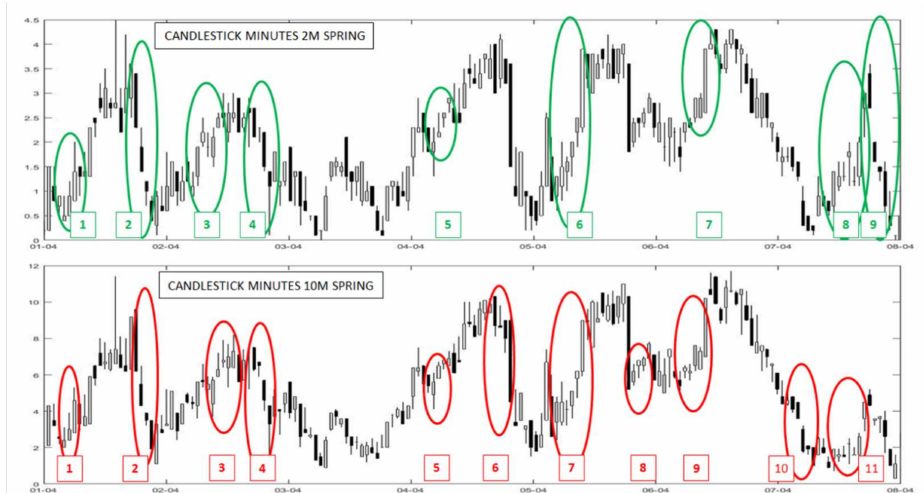
Figure 6. Candlestick chart for Los Montes del Cierzo, hourly resolution, first week of April 2017, at 2 m ( top ) and 10 m ( bottom ) above the